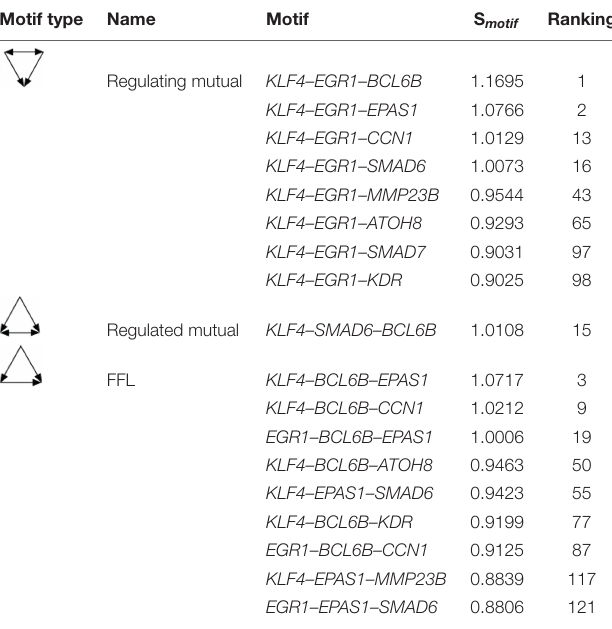
TABLE 7 | The motifs formed between the “ KLF4–EGR1–BCL6B ” complex and its regulatory genes in the lung.